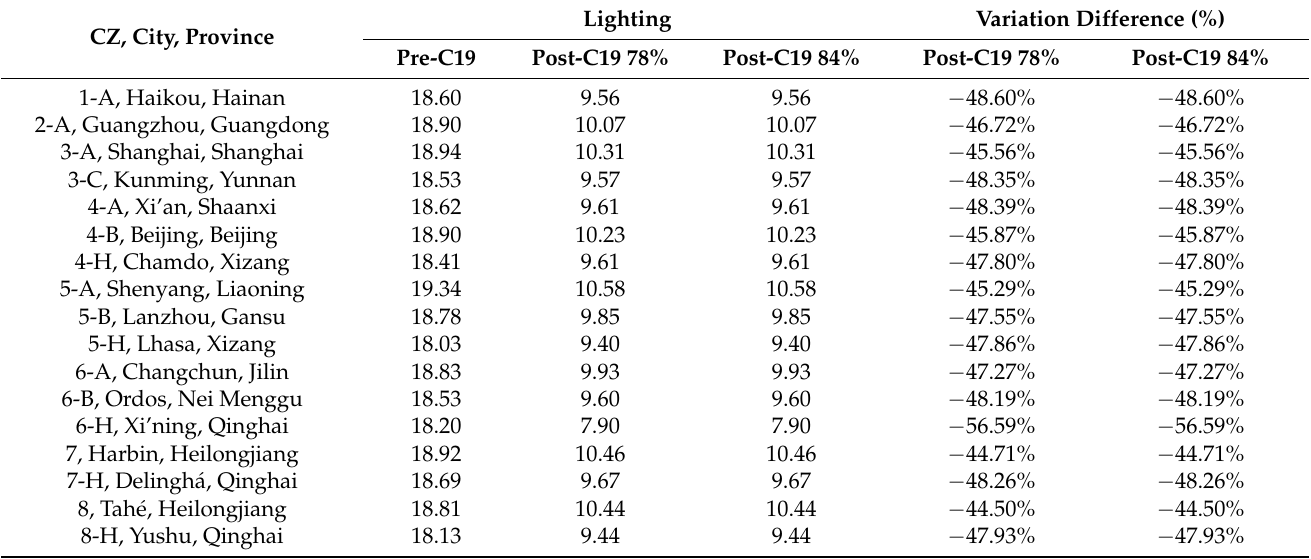
Table A2. Lighting EUI per location in pre- and post-C19